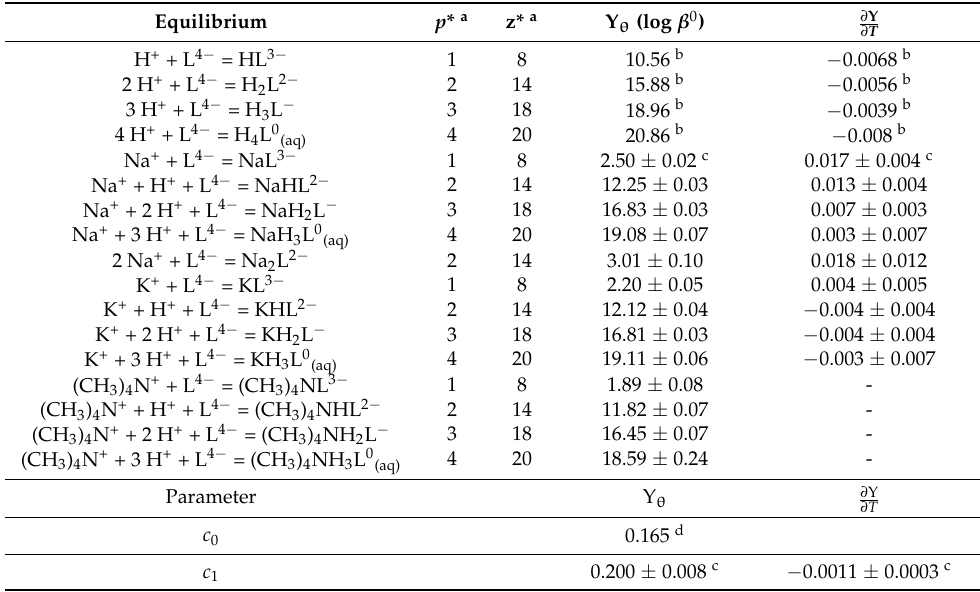
Table 5. Equilibrium constants at infinite dilution, temperature and ionic strength dependence parameters of the weak species for GLDA (L) at T = 298.15 K and p = 0.1